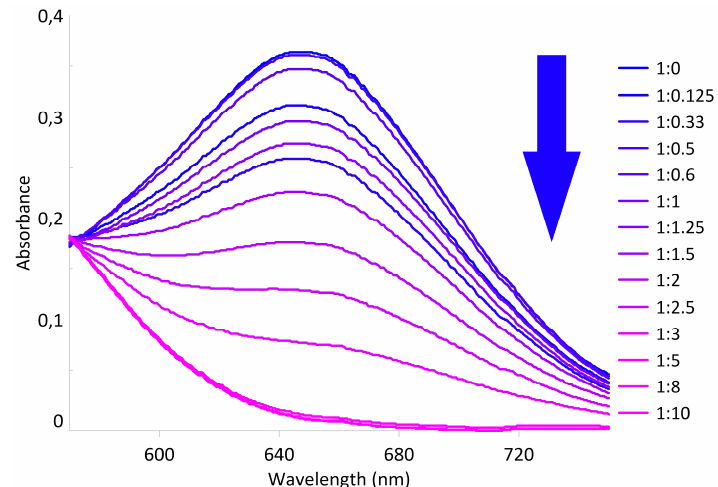
Figure 4. The absorption band of complex PhTz : 4 (equimolar mixture, C = 1 × 10 − 5 M) at different ratios of the dihydrogen phosphate anion. Ratios of [ PhTz ]:[H 2 PO 4 − ] are listed on the inset.